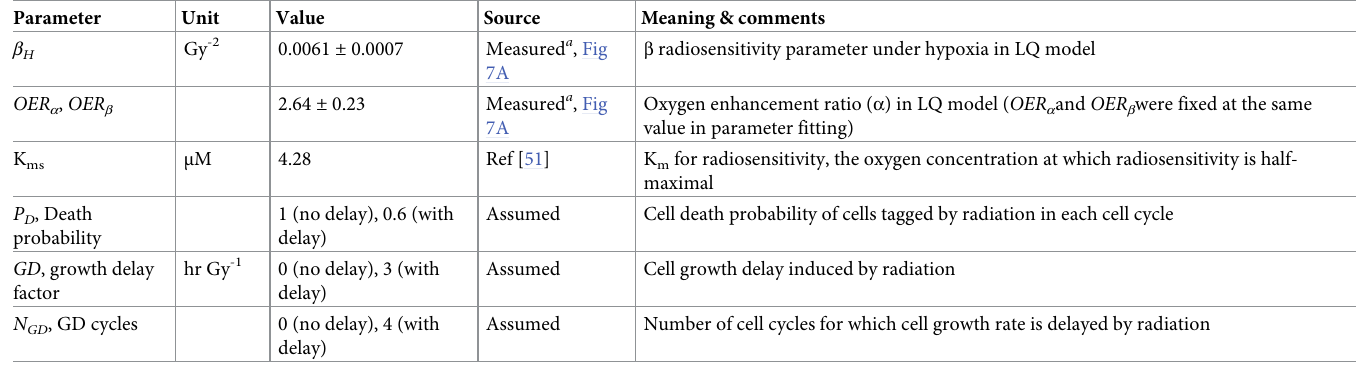
microporous Teflon support membrane ( D